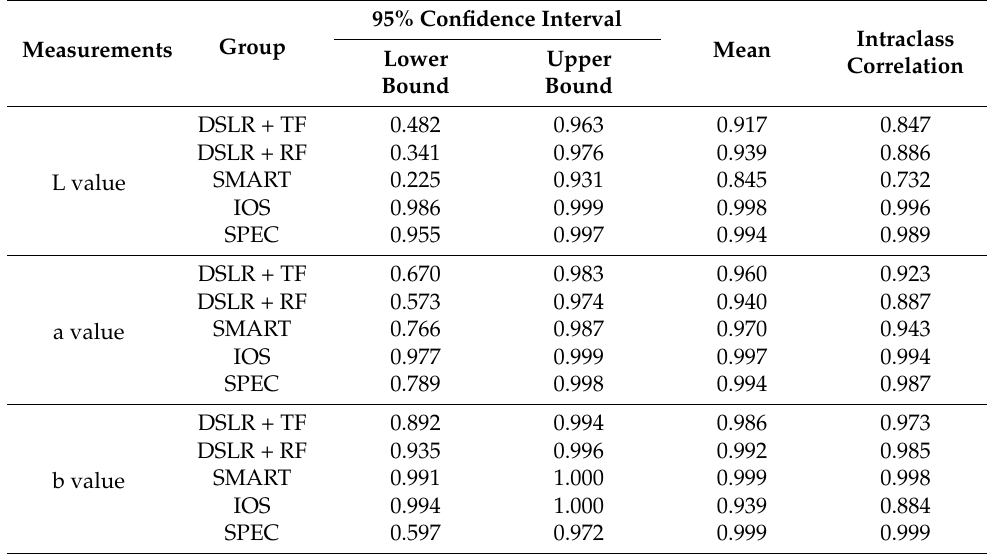
Table 3. Reliability: the intraclass correlation of CIE Lab values from study groups.